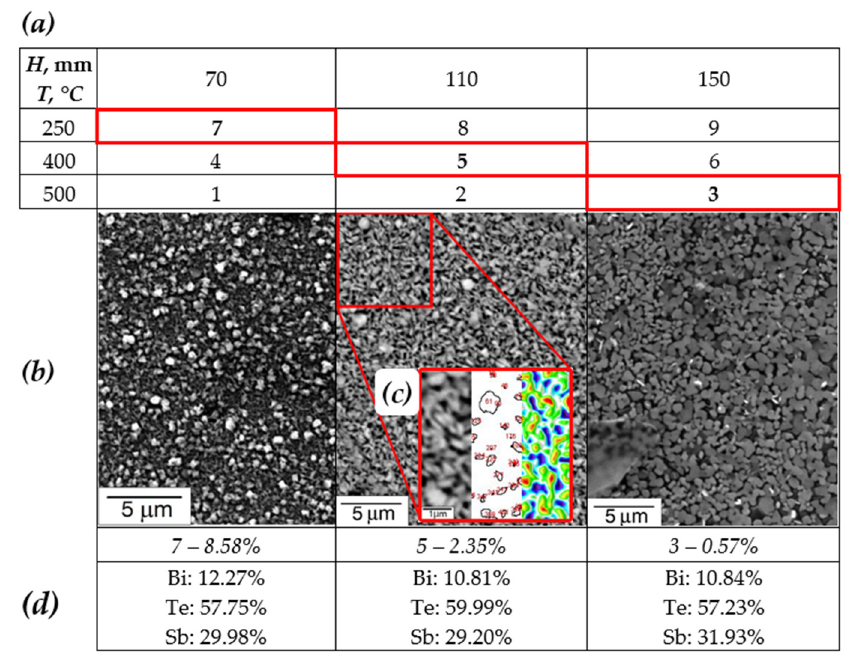
Figure 2. The results of the study of the droplet fraction on the surface of thin films: ( a ) the plan of the experiment where the red borders of the cell indicate the samples selected for analysis; ( b ) images of the microstructure of the samples; ( c ) example of image processing by the ImageJ package; ( d ) EDS results for selected samples.